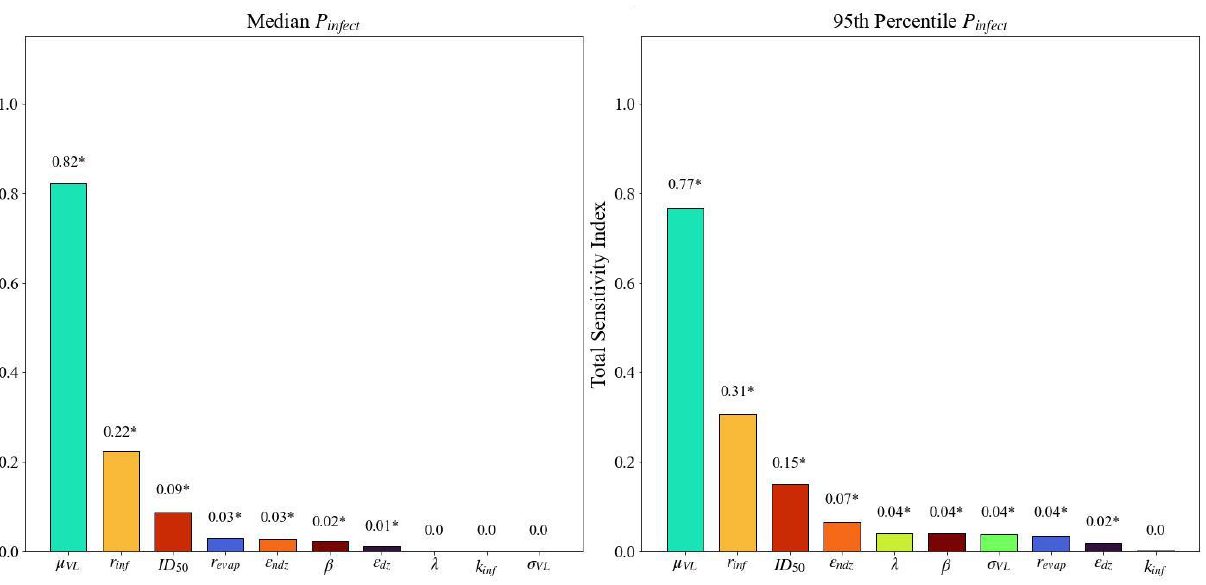
Figure 11 . Total sensitivity indices (ordered from largest to smallest) derived using eFAST for the median 𝑃 𝑖𝑛𝑓𝑒𝑐𝑡 and 95th percentile of 𝑃 𝑖𝑛𝑓𝑒𝑐𝑡 with coughing as the emission mechanism. Asterisks (*) indicate statistically significant sensitivity indices ( 𝛼 = 0.01 ). Table 3. Ranking of the total sensitivity indices for the median and 95th percentile 𝑃 𝑖𝑛𝑓𝑒𝑐𝑡 with breathing and coughing as the emission mechanisms. Yellow shaded cells indicate parameters that were determined to be statistically significant.